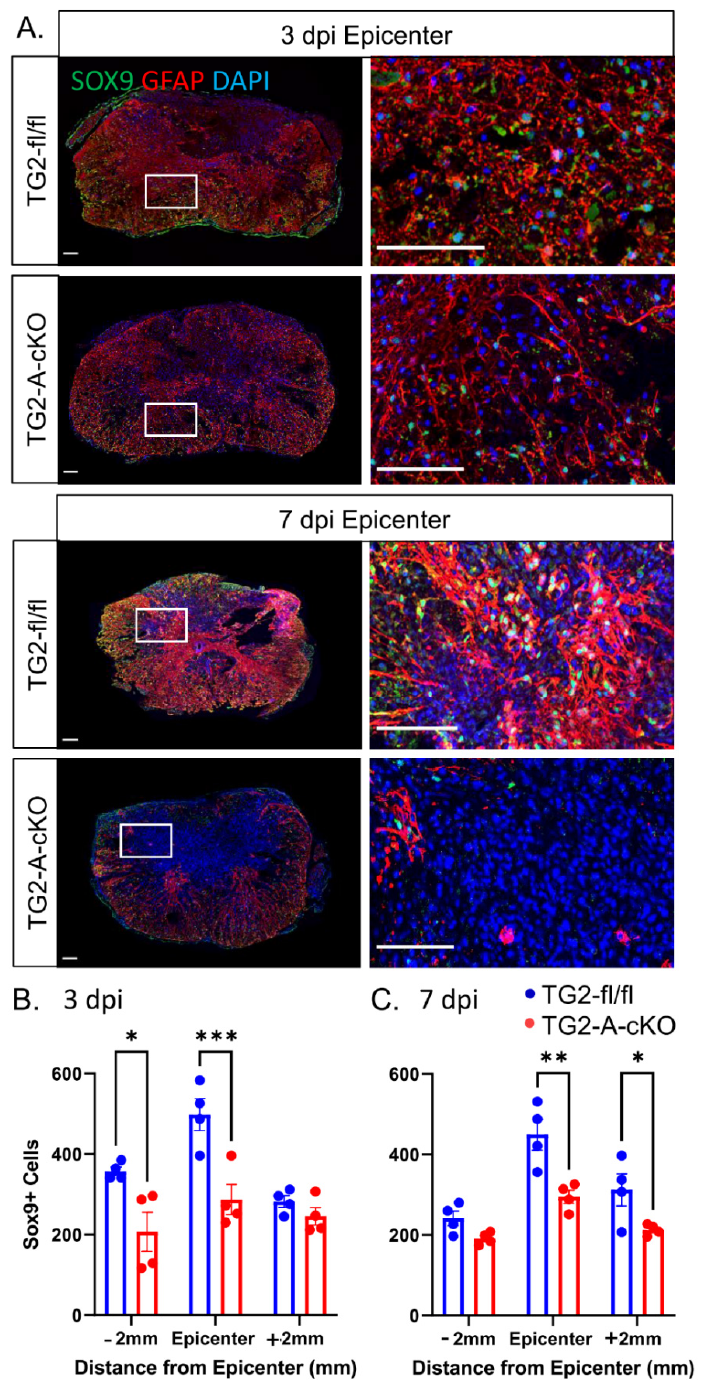
Figure 4. Deletion of TG2 from astrocytes results in a significant decrease in SOX9 positive cells after spinal cord injury. Spinal cord sections were immunostained for SOX9 (green), GFAP (red) and counterstained with DAPI (blue). ( A ) Representative images of 3 and 7 days post-injury (3 dpi, 7 dpi) at the epicenter of the injury. Scale bars = 100 µm. ( B , C ) The number of SOX9 positive cells was determined +/ − 2 mm from the site of injury as well as the epicenter. At 3 dpi, the number of SOX9 positive cells in TG2-A-cKO mice was significantly decreased at both at − 2 mm and the epicenter. At 7 dpi, there was still a significant decrease in the number of SOX9 cells at the epicenter in TG2-A-cKO mice, as well as at +2mm to the injury site. * p < 0.05, ** p < 0.01, *** p < 0.001. N = 4 animals per group.